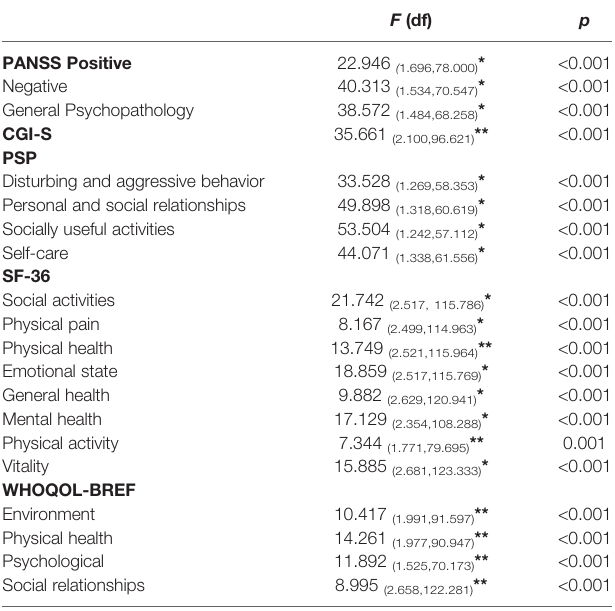
TABLE 2 | Within-group main effects of time, Mauchly ’ s Tests of Sphericity are statistically signi fi cant.